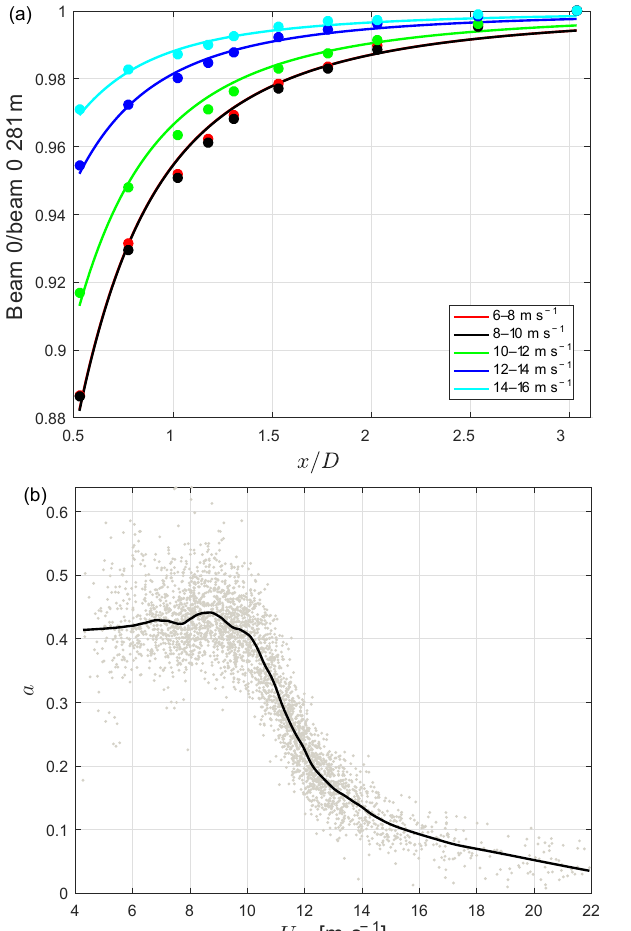
Figure 3. (a) U ( x ) /U ∞ as a function of the upstream distance from the rotor averaged over different intervals of U ∞ . The curves are fits to Eq. (1). (b) The induction factor a determined by fitting Eq. (1) to 10min means of the lidar measurements. The black curve is based on interval